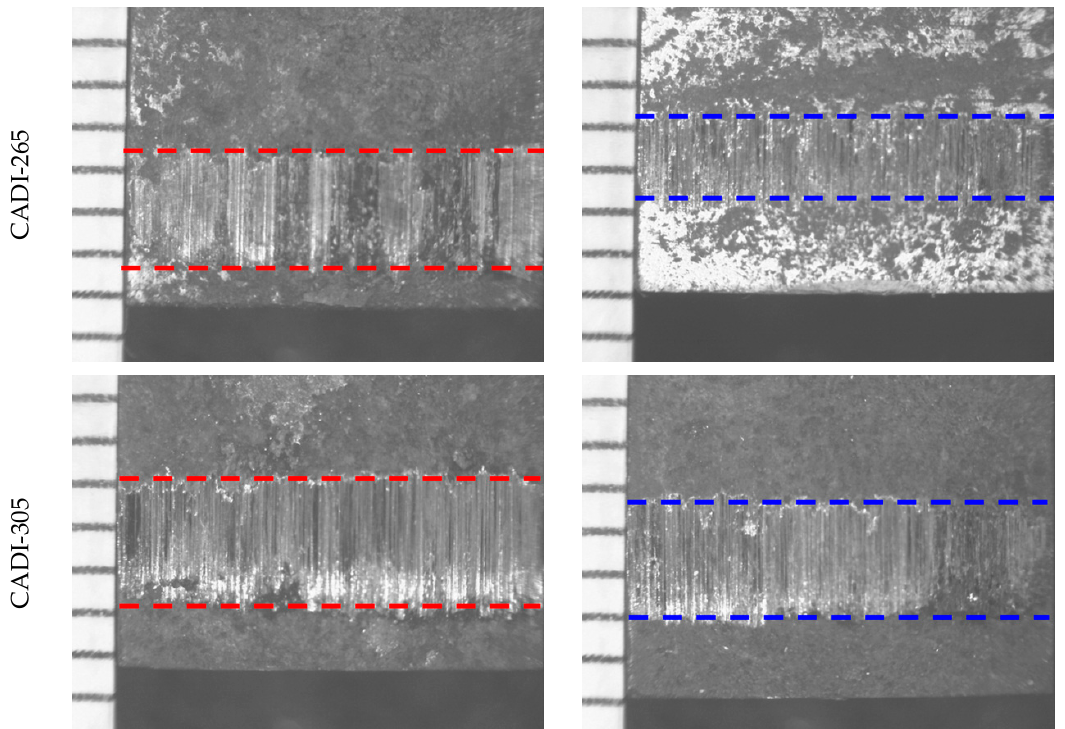
Figure A4. Wear scars samples for DI and CADI alloyed with 0.2 and 0.4% Cr, austempered at 265 and 305 for 90 min.